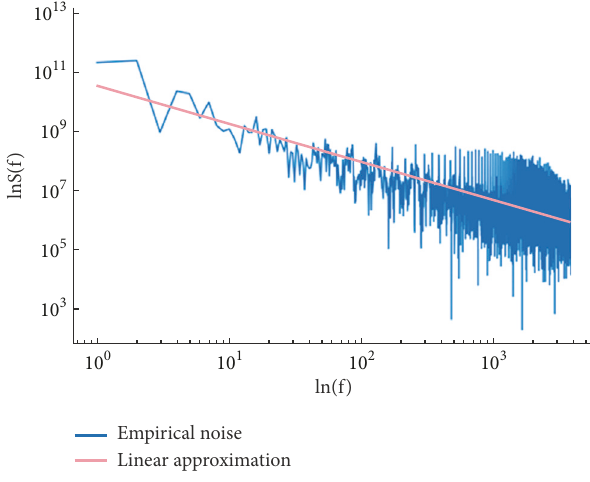
Figure 4: PSD for empirical time series 𝑀𝑃 𝑡 .